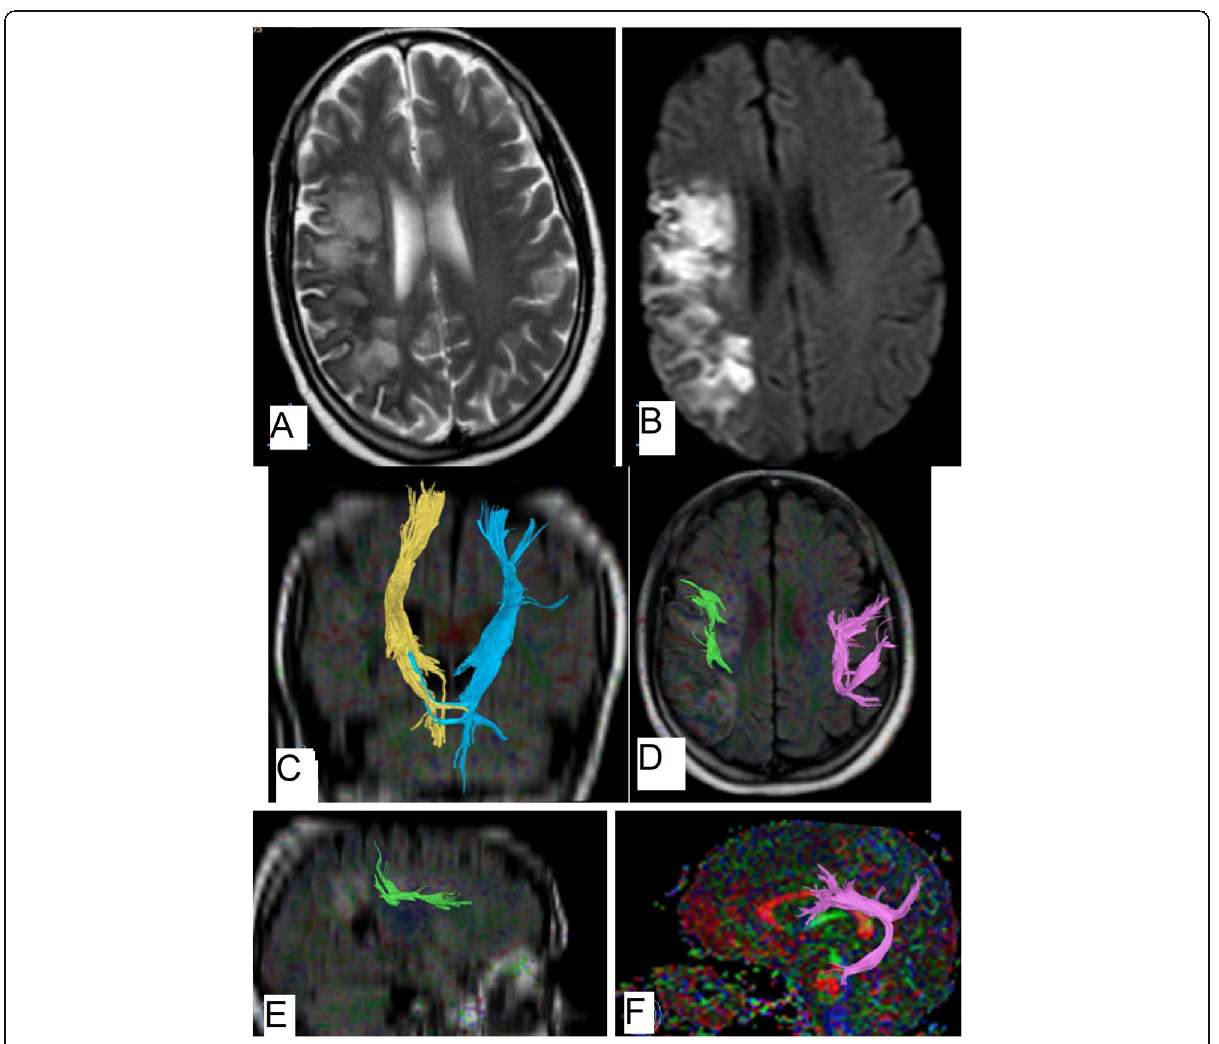
Fig. 3 A 57-year-old female patient, diabetic and hypertensive, presented with dysarthria. NIHSS on admission was 7 a axial T2 b axial diffusion WIs (b1000) show right fronto-parietal area of high signal and restricted diffusion in keeping with acute infarct. c Coronal FA color-coded map overlaid over coronal FLAIR image with fiber tractography of the CST that appear preserved. d Axial FA color-coded map overlaid over axial FLAIR image with tractography of the acurate fasciculus. e Sagittal FA color-coded map overlaid over sagittal FLAIR image with tractography of the right arcuate fasciculus. f Sagittal FA color-coded map with tractography of the left arcuate fasciculus. Note the disrupted right arcuate fasciculus (green) compared to the left one (pink). FA value at the site of infarct (0.3) compared to the contralateral normal side (0.4). The patient